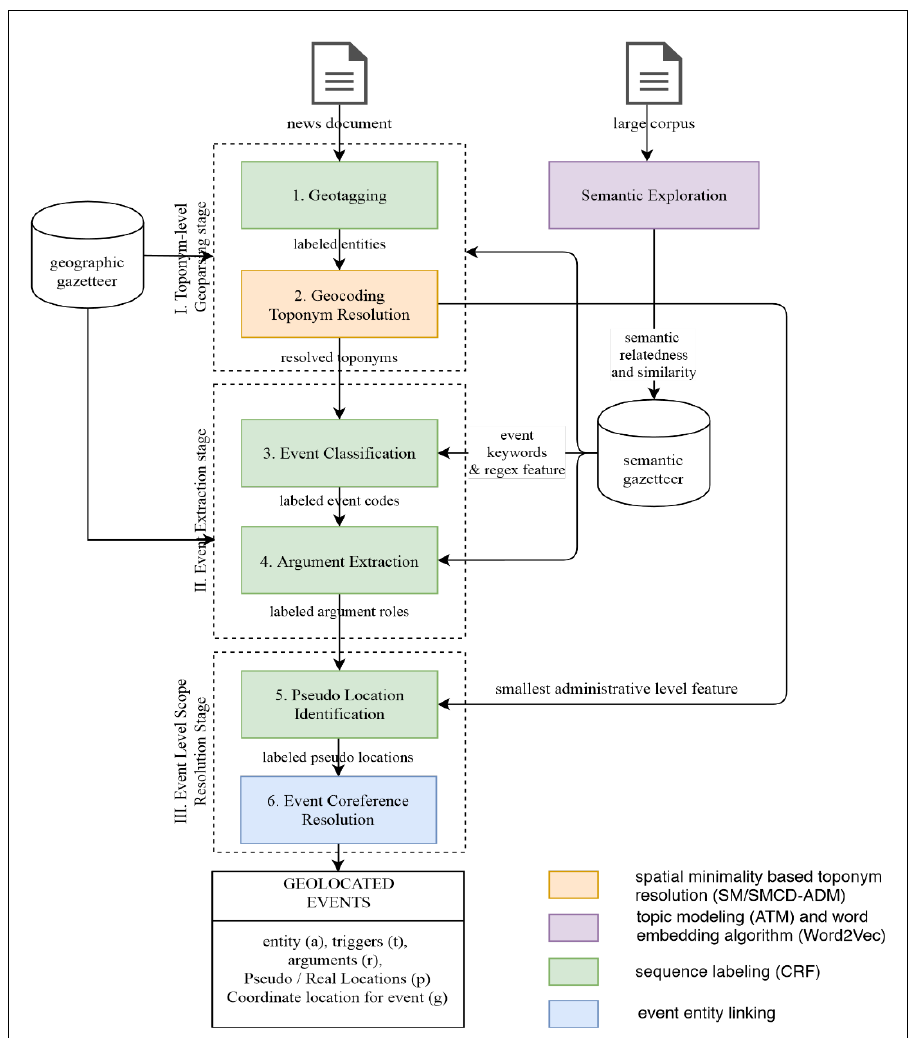
Figure 5. Integrated Event Extraction and Geoparsing: accept news document as input, resolving toponym and other entities (a), event triggers type (t), arguments (r), and event locations (g) from text. It is chaining geotagging with toponym resolution and event extraction. The system uses semantic gazetteer for features and regular expression rules learned from large corpus to increase the precision, recall, and geoparser